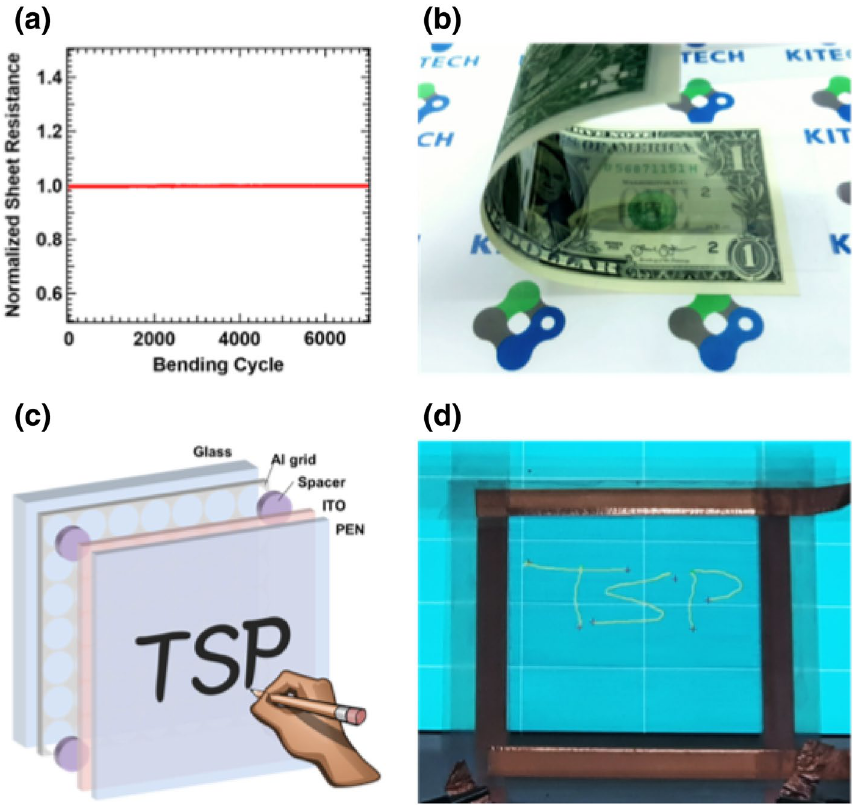
Figure 7. ( a ) Measured normalized sheet resistance during the mechanical bending test with a 5 mm bending radius. ( b ) Flexible transparent electrode demonstrated on a one-dollar bill. ( c ) Schematic illustration of a touch screen panel (TSP) ( d ) TSP operation on an LCD screen. “TSP” was written on